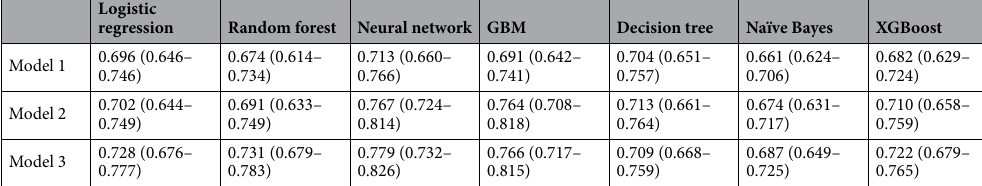
Table 2. Comparison of area under the receiver operating characteristic curve (AUC) by Machine Learning Algorithms in Parkinson’s disease prediction according to different included variables. Model 1: Including sex, SES and comorbidities. Model 2: Including sex, SES, comorbidities and lifestyle factors. Model 3: Including sex, SES, comorbidities, lifestyle factors, and anthropometric and laboratory data. GBM gradient boosting machines, XGBoost eXtreme gradient